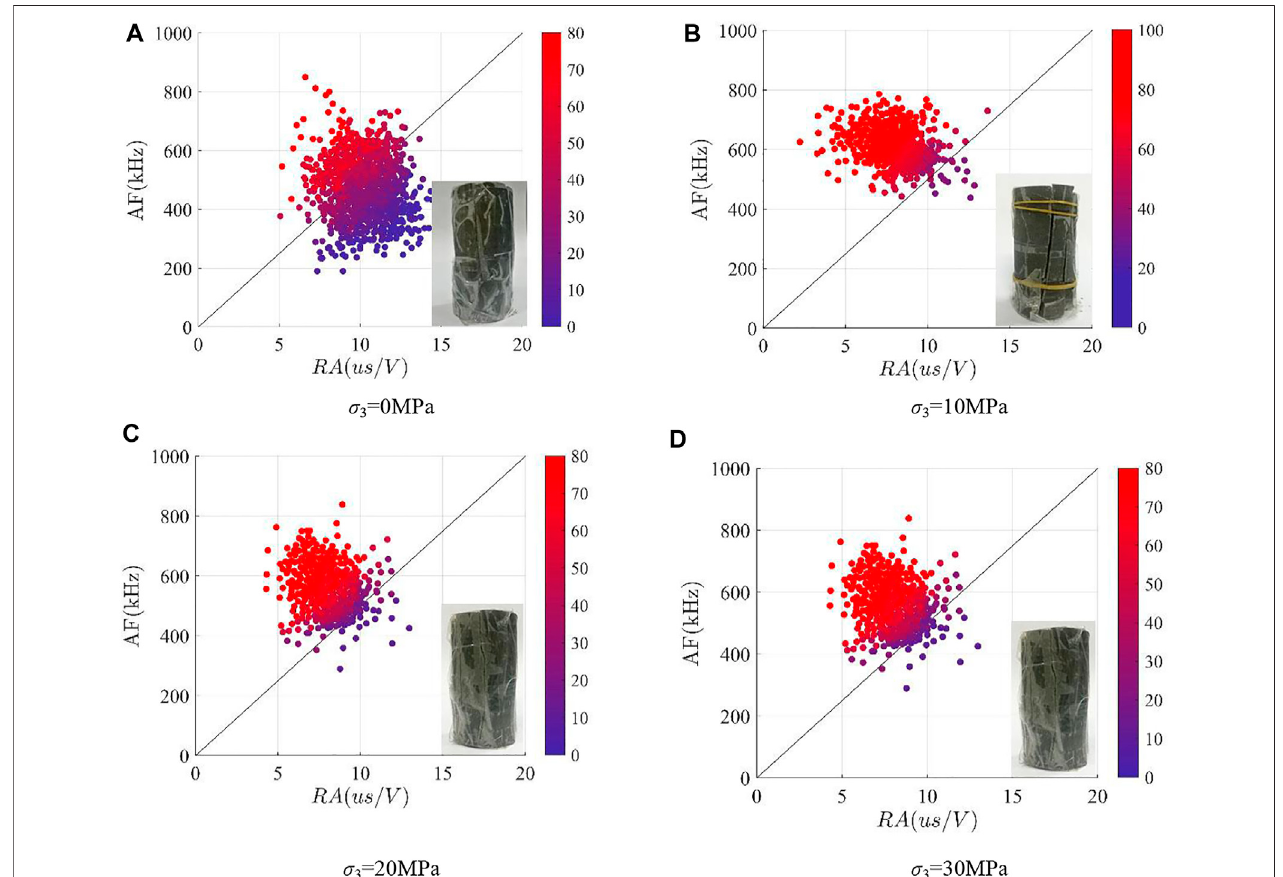
FIGURE 12 | WCP in the AF-RA plane and FMI. (A) σ 3 = 0 MPa, (B) σ 3 = 10 MPa, (C) σ 3 = 20 MPa, and (D) σ 3 = 30 MPa.